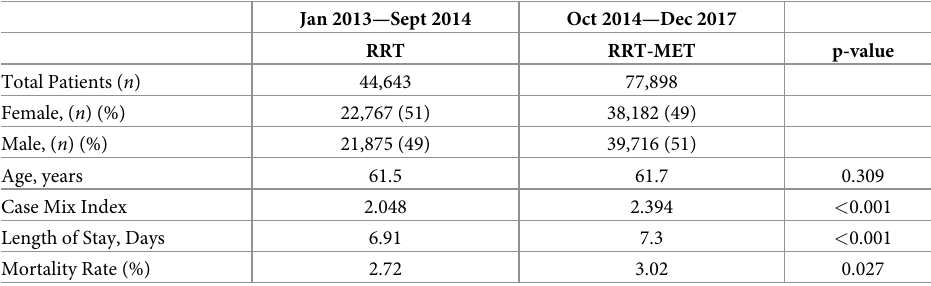
Table 1. Baseline